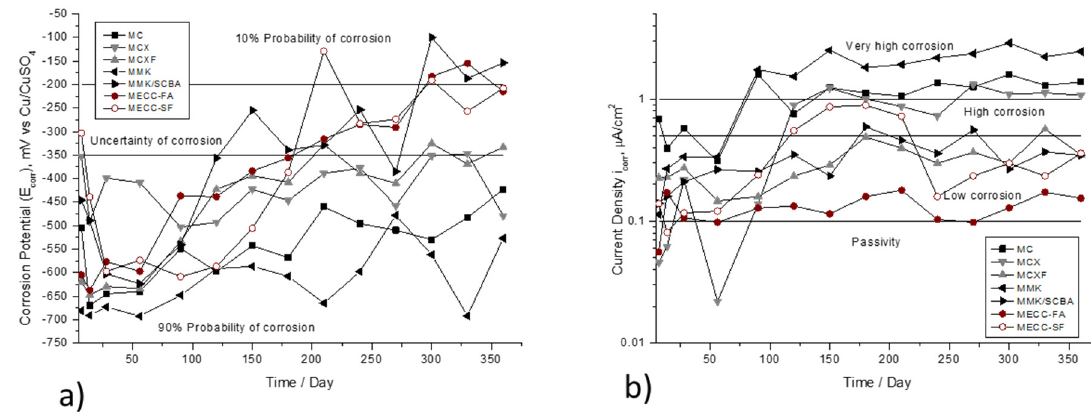
Figure 3. Corrosion behavior of AISI 1018 CS in mortars exposed in 3.5 wt % NaCl solution. ( a ) Half- cell potential (E corr ). ( b ) Current density (i corr ).